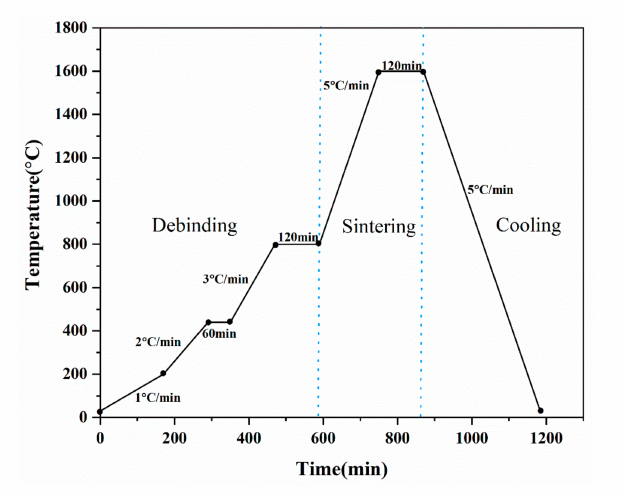
Figure 3. Debinding and sintering curves of composite